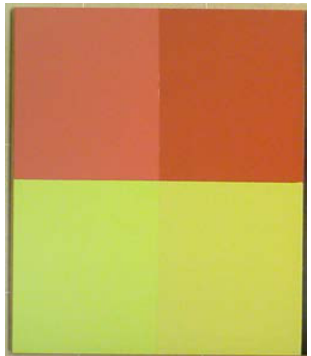
Figure 6. The project of the segment no 3: Various materials